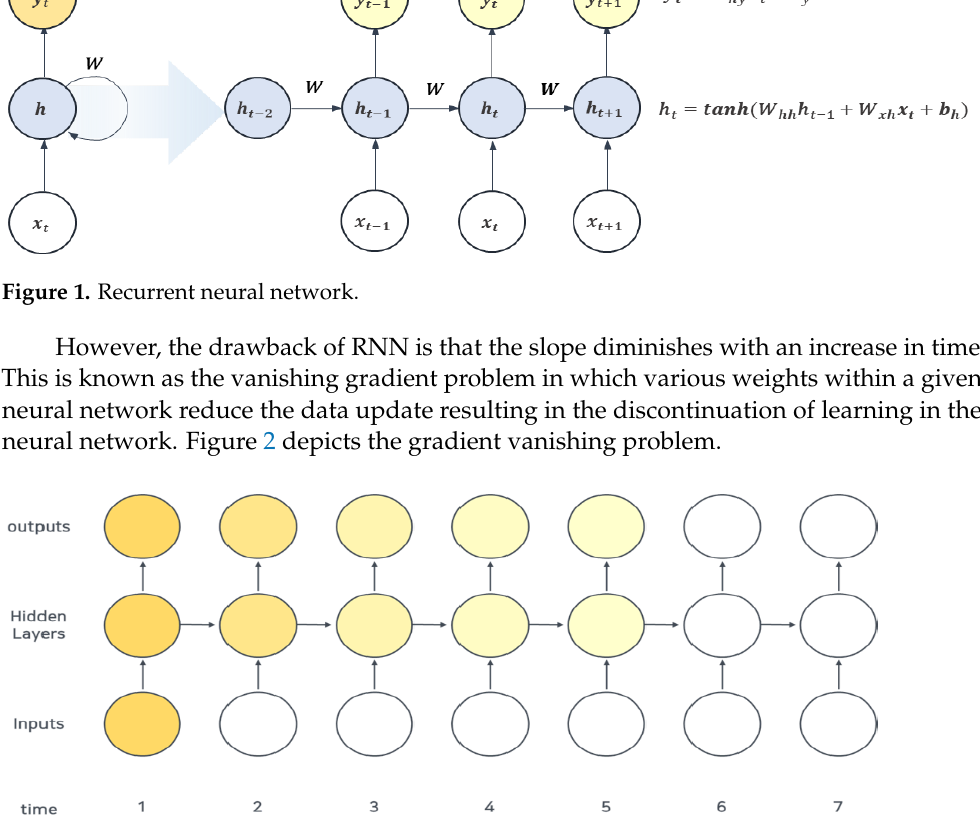
Figure 2. Gradient vanishing visualization.